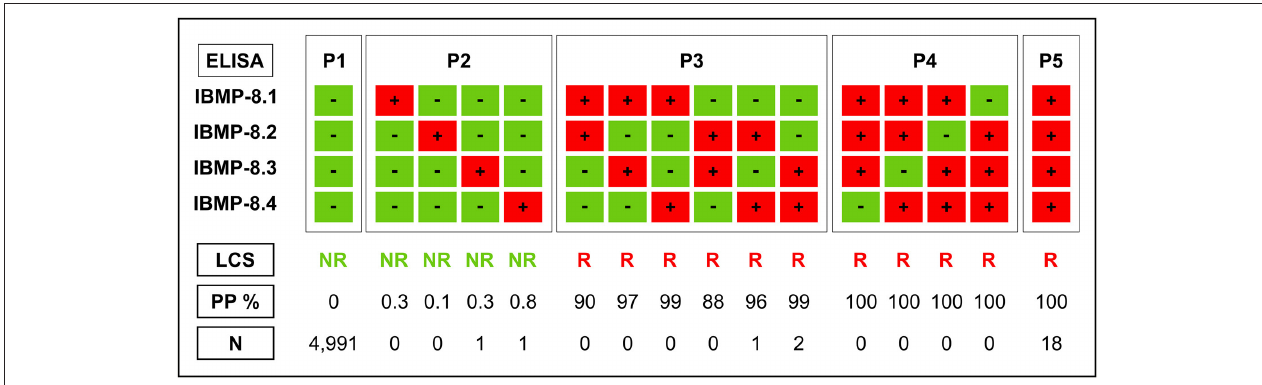
FIGURE 1 | Response patterns of chimeric antigens in latent class analysis (LCA) used in anti- T. cruzi ELISA tests in HEMOBA Foundation blood donor volunteers between December 2018 and August 2019. LCS, latent class status; NR, non-reactive; PP, a posteriori probability; R, reactive; P1, P2, P3, P4, and P5, reaction response; N, number of